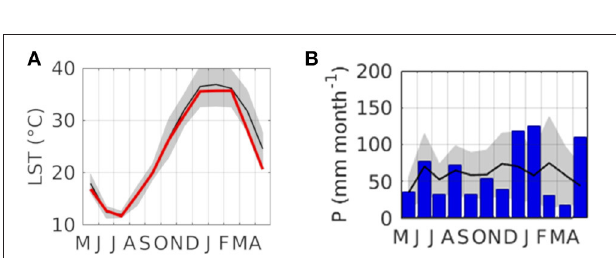
FIGURE 2 | Study site satellite derived climatic variables sampled at Mullunggari Nature Reserve (center pixel) (A) temperature from MODIS Terra Global Land Surface Temperature (LST; ◦ C) (MOD11A2) mean (black line) and standard deviation 1998–2017 (gray area) and this study period (May 2014–April 2015; red line) (B) precipitation (P; mm month-1) from the version 7 Tropical Rainfall Measuring Mission (TRMM) data product (3B43-v7) (0.25 deg) mean (black line) and standard deviation 1998–2017 (gray area) and this study period (May 2014–April 2015; blue bars).